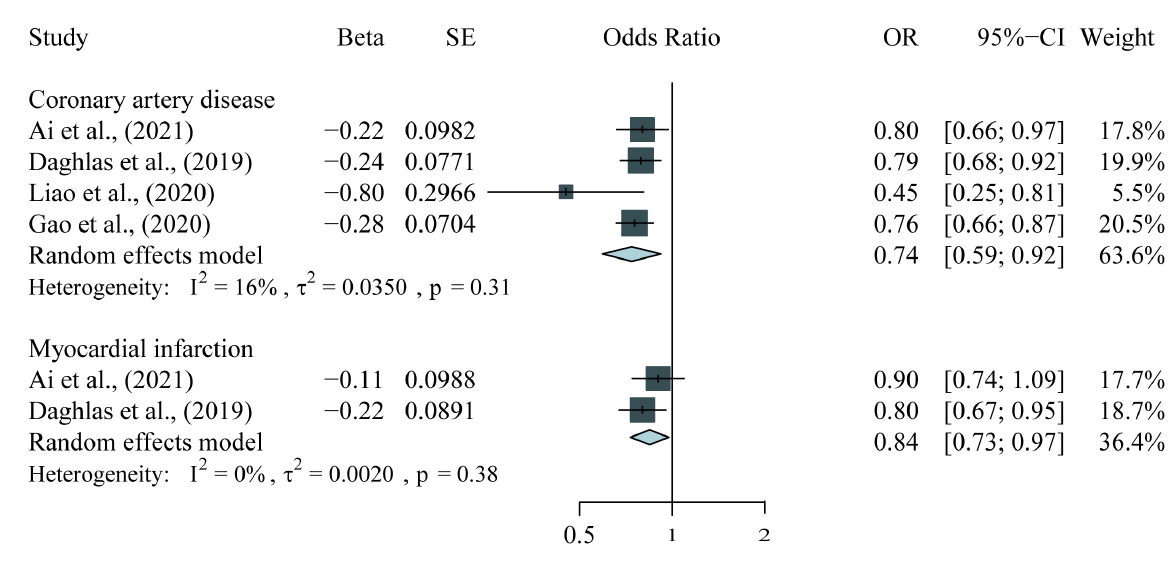
FIGURE4 Meta-analysis results for the association between per hour longer sleep duration and CVDs in MR